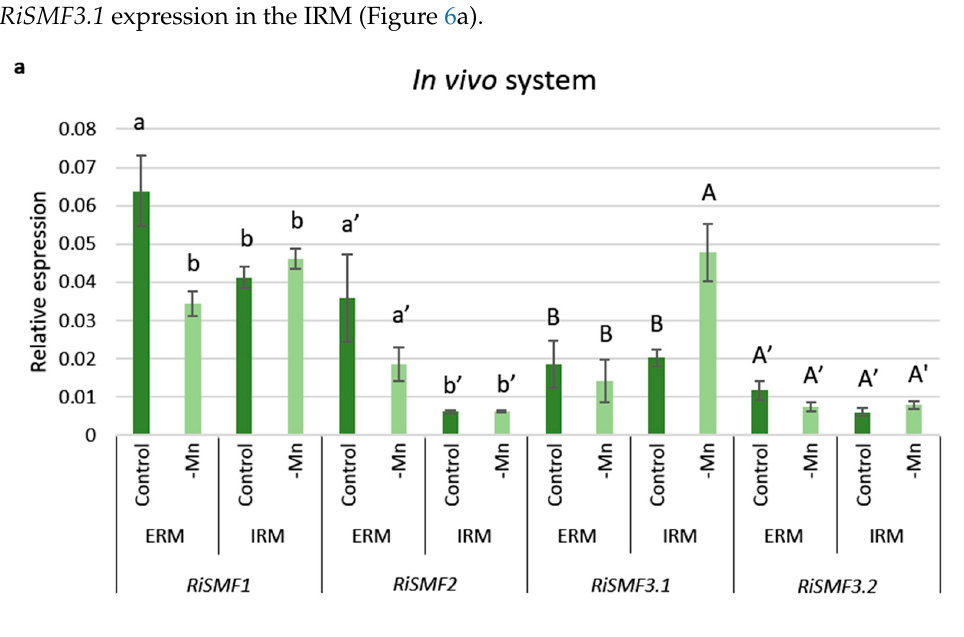
Figure 6. Effect of Mn deficiency on RiSMF s expression. ( a ) Gene expression was analysed in RNAs isolated from mycorrhizal roots (IRM) and ERM collected from chicory plants, developed in the whole-plant bidimensional culture system (in vivo system) and watered with half-strength Hoagland solution (control, 4.5 µM) or a modified nutrient solution without Mn (-Mn). ( b ) Gene expression was analysed in RNAs isolated from ERM developed in monoxenic cultures (in vitro system) in liquid M media without Mn (-Mn) or containing 2 µM Mn (control). Relative-gene- expression levels were calculated, using the 2 −Δ CT method with RiEF1 α as internal control. Bars represent standard error. Different letter types indicate statistical data for each gene. Different letters indicate significant differences ( p < 0.05; n = 3) between treatments. The effect of Mn availability on RiSMF s expression was also analysed in RNAs iso- lated from ERM grown in vitro in monoxenic cultures with and without Mn. Expression of none of the RiSMF genes was significantly affected by Mn deficiency in the ERM grown in the in vitro culture system (Figure 6b). 3.5. Impact of Fe availability on RiSMFs Expression Taking into account that fungal NRAMPs are regulated by Fe and that RiSMF3.2 has an Fe transport function, the effect of Fe availability on RiSMF s expression was assessed, to get further insights into their roles in R. irregularis . Firstly, the effect of Fe starvation